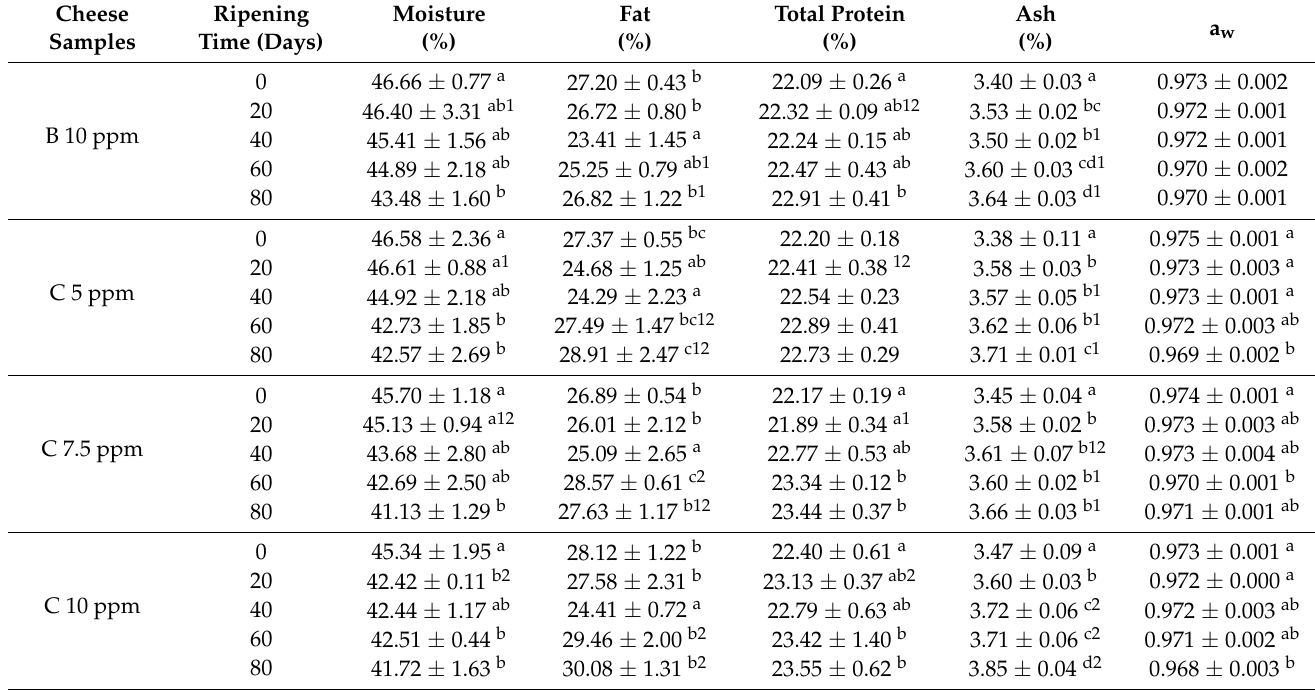
Results are expressed as mean ( n = 3) ± standard deviation. a–d Means in each column with different letters were significantly affected by ripening time ( p < 0.05); 1,2 means in each column with different numbers were significantly different between cheese samples at a similar ripening time ( p < 0.05). a w = water